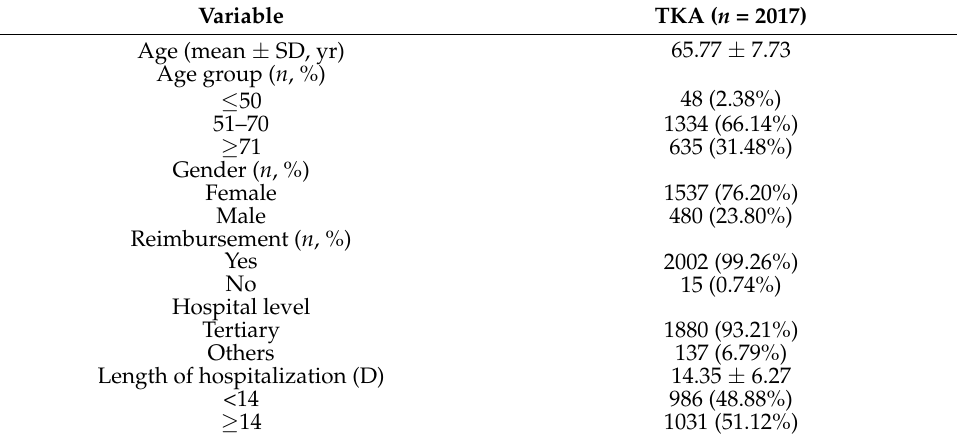
Table 1. Basic characteristics of TKA patients ( n = 2107).